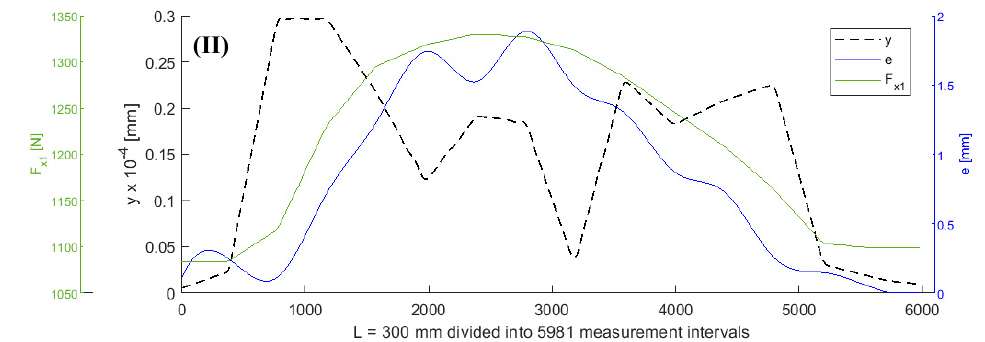
Figure 4. Curves of objective function y, tensile force Fx 1 , and eccentricity e for d = 6 mm, F be =70 N, F x10 = 980 N, L = 300 mm, F f =40 N.